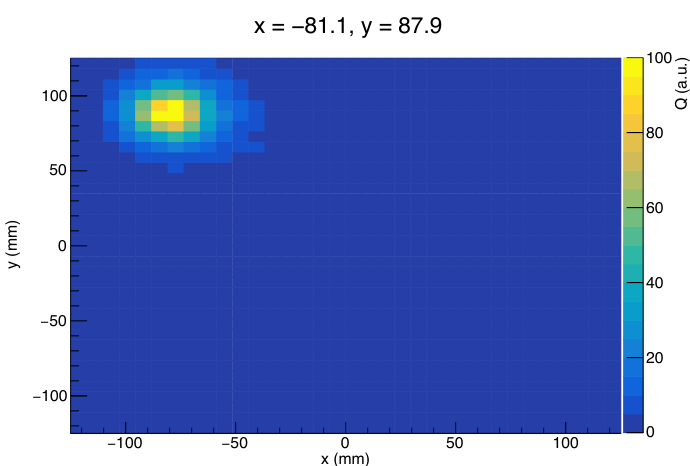
Figure 2. Charge distribution on the inner readout for one event. The initial photon entered at x = − 81.1mm, y = 87.9mm (Monte Carlo truth value). The charge is arbitrarily scaled.